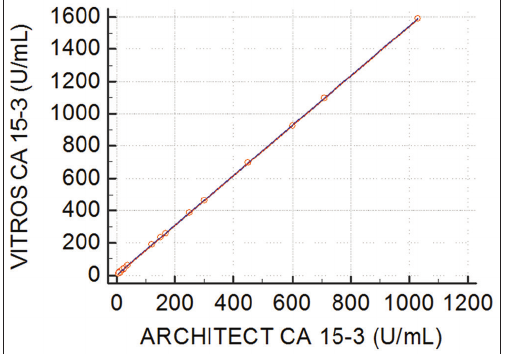
FIGURE 2. Comparison of cancer antigen (CA) 15-3 anti- gen determined in human serum samples using ARCHITECT i2000SR immunoassay analyzer and VITROS 5600 Integrated System (r = 1.00).